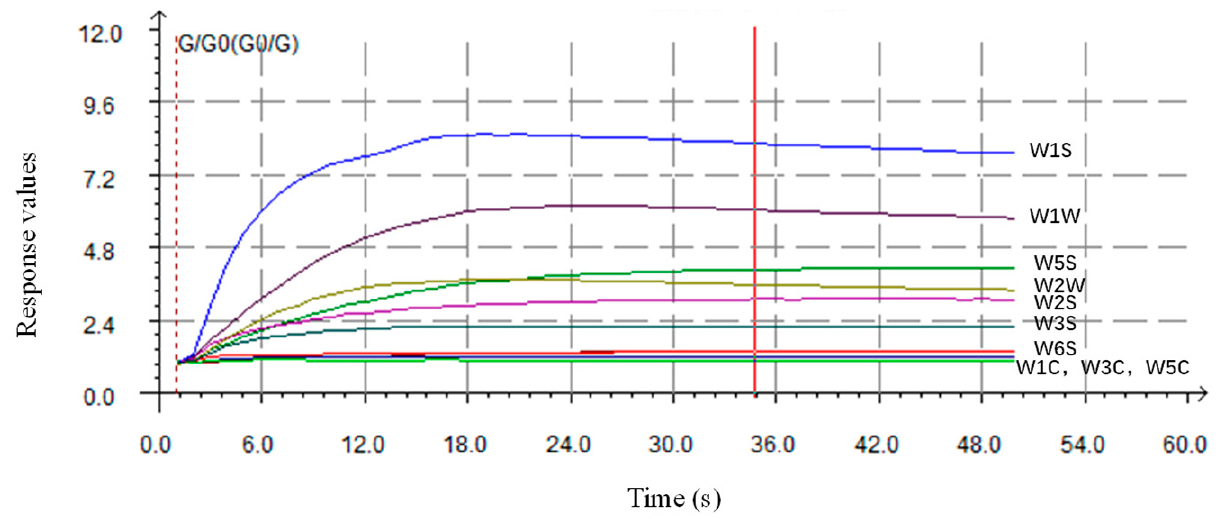
Figure 1. Aroma response values detected by the ten sensors for the peach flower ‘Hongfenjiaren’.